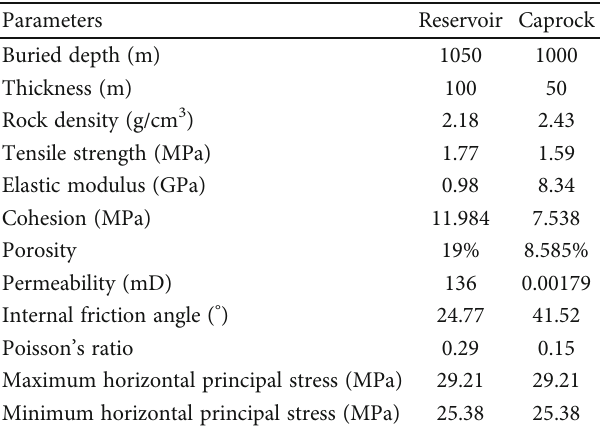
Figure 3: Diagram of conceptual model and grid partition (one side of injection well). Table 1: Parameters of reservoir caprock